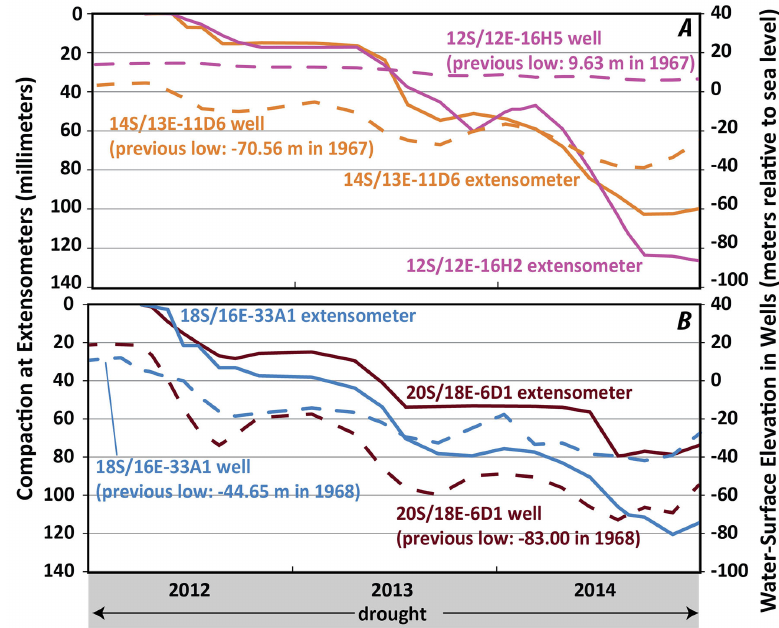
Figure 3. Graphs showing compaction and water-surface elevation at selected extensometers and associated wells for 2012–2014 near (a) . the El Nido subsidence area and (b) . the Pixley subsidence area. (See Fig. 1 for extensometer and well